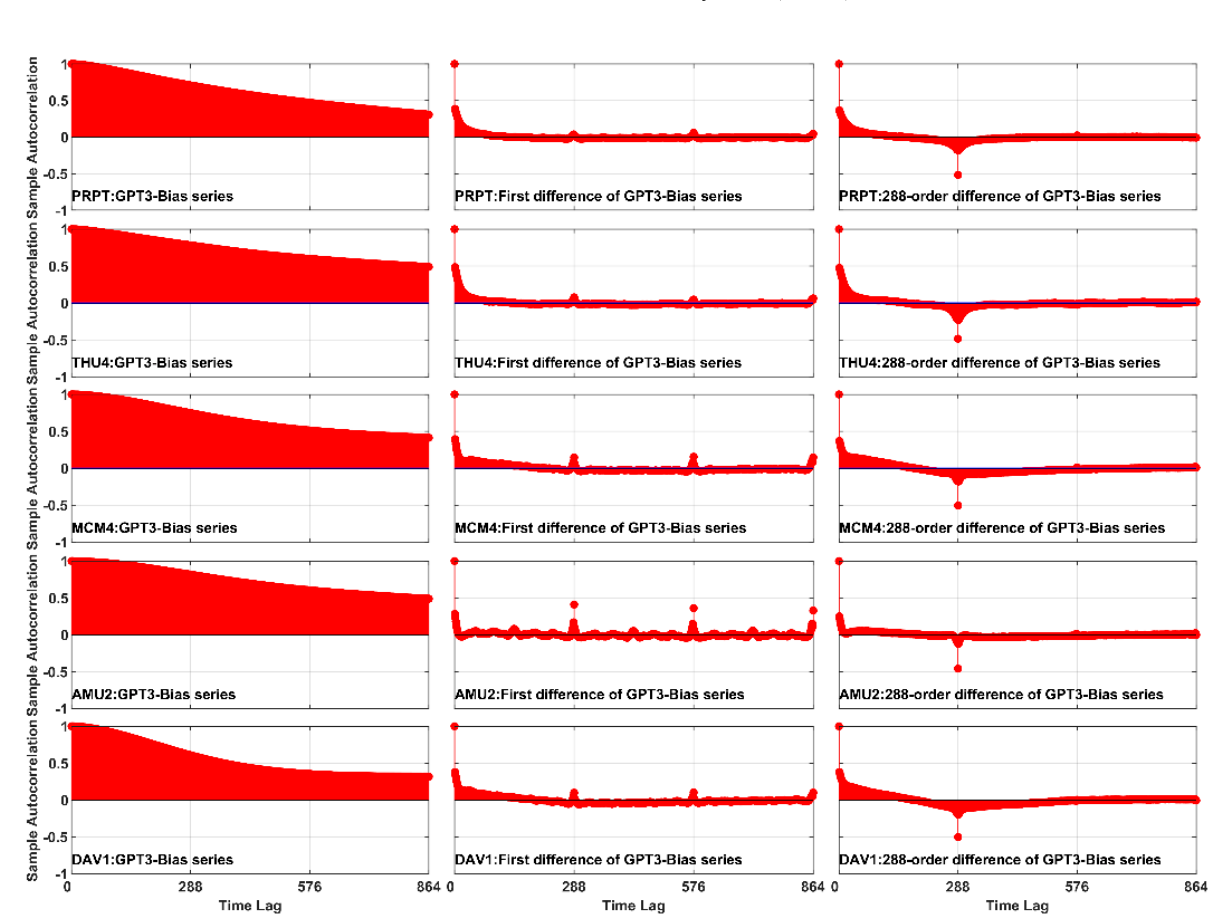
Figure 5. Autocorrelation function of bias series between GPT3_ZTD and GNSS_ZTD at PRPT, THU4, MCM4, AMU2 and DAV1 station.